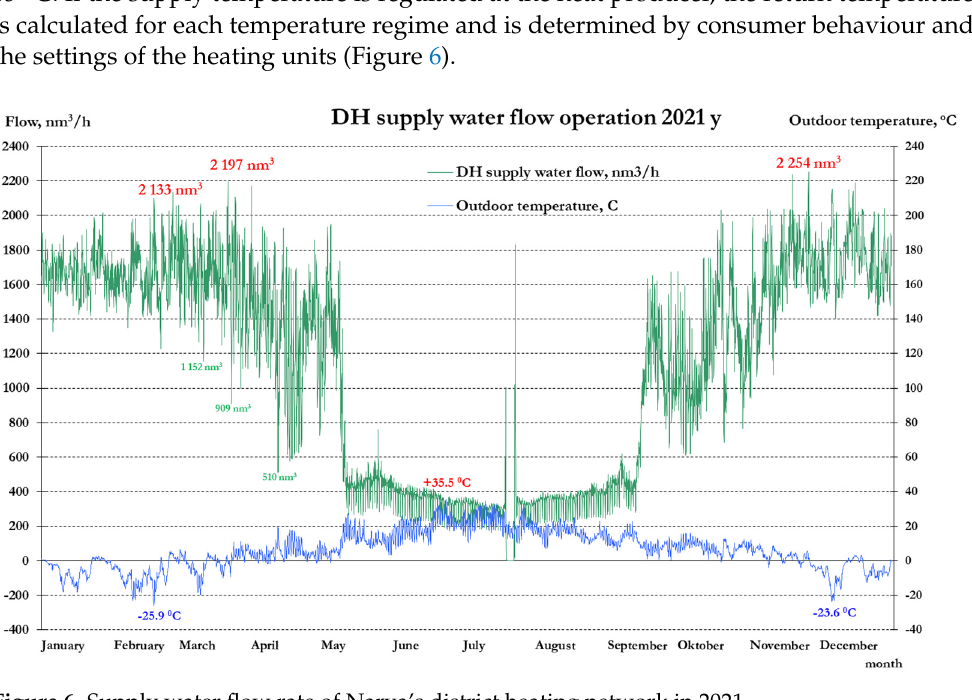
Figure 7. Narva district heating average annual duration curves. 3.2. Optimal Scenario Indicators 3.2.1. Energy Efficiency The efficiency of power production is calculated using electrical efficiency: 𝜂 (cid:3032)(cid:3039) =